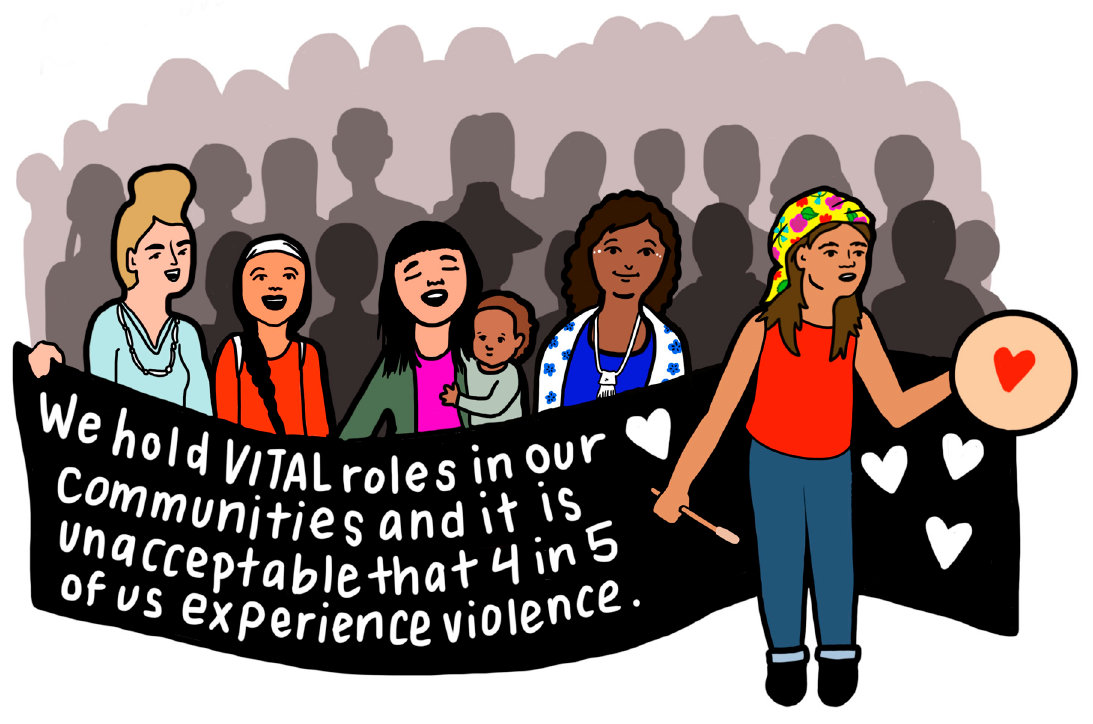
Figure 1. This image states that 4 out of 5 Native women experience violence in their lifetime and emphasizes the strengths of Native women. See Image Descriptions (I.D.) 1 in Appendix A.